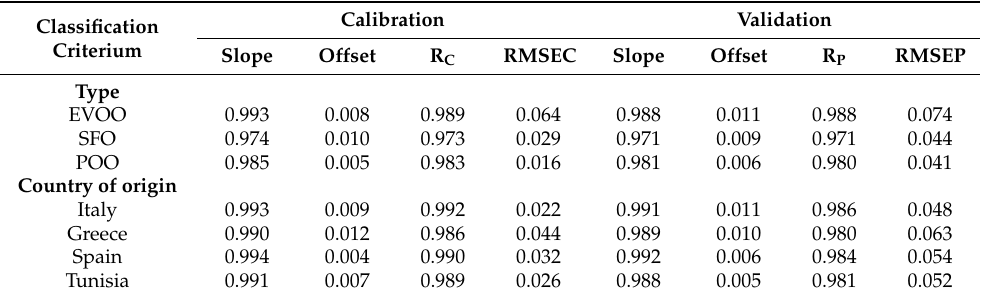
Table 2. Quantitative data of the PLS-DA regression using voltammetric data for two classifica- tion